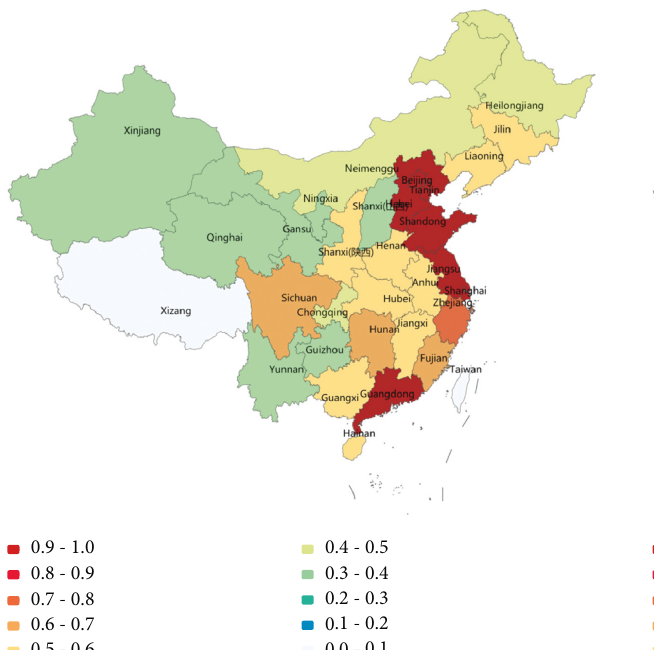
Figure 5: 2016 EEE value in China.